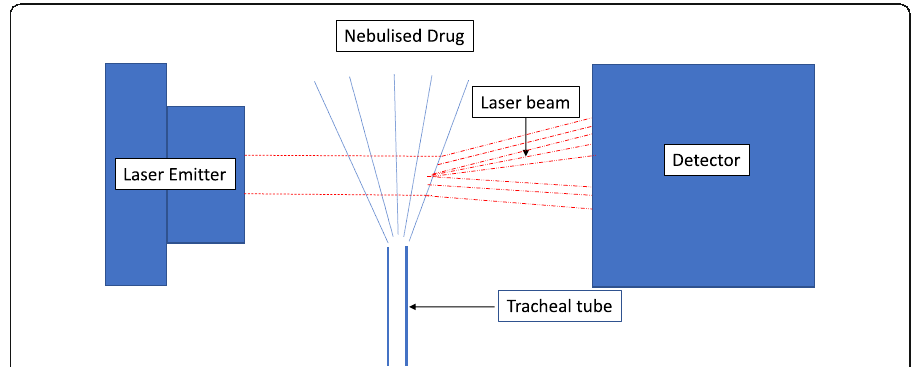
Fig. 1 Principle of laser diffraction technique for particle